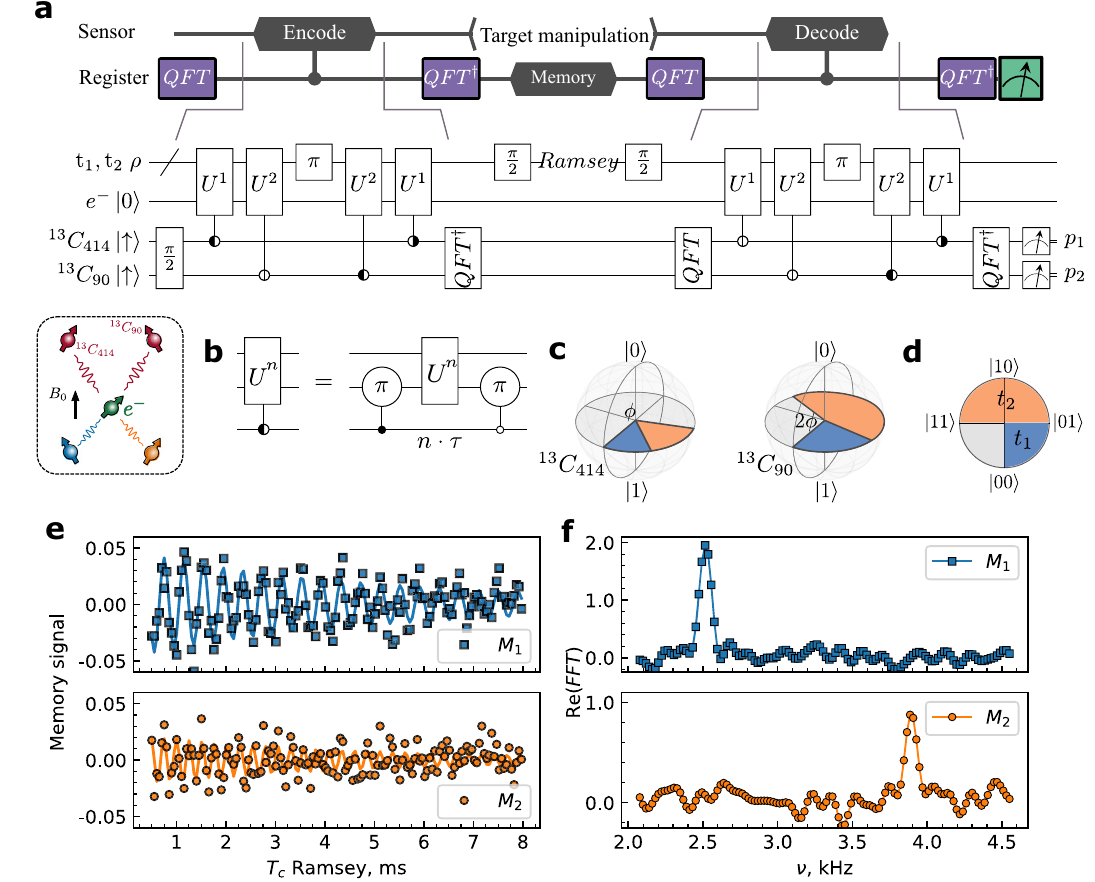
Fig. 3 High resolution correlation spectroscopy of target nuclear spins with Quantum Fourier Transform. a 5-qubit circuit for high resolution spectroscopy. Metrology information is decoded fi rst with a single quantum phase estimation algorithm step and with a fi lter to preselect the target spins of interest. b Controlled unitaries U n consist of two CROT gates with different states of the control qubit separated by n τ . The unitary is realized though A zz I z S z interaction. c Representation of the phase acquired by two register qubits. The phase results from two target spin contributions proportional to their coupling strength and conditional on the target spin state. The net amount of phase on the second qubit is twice larger than on the third in order to match the requirement of the QFT transformation. d Acquired phase digitization on register states. First target spin is responsible for the fl ip of least signi fi cant qubit, while second target spin is responsible for the fl ip of most signi fi cant qubit. e Ramsey measurement on two target spins as shown in ( a ). After performing a FFT on the data (shown in ( f )), two distinct peaks arise with a linewidth of a 100 Hz allowing to distinguish between the two target